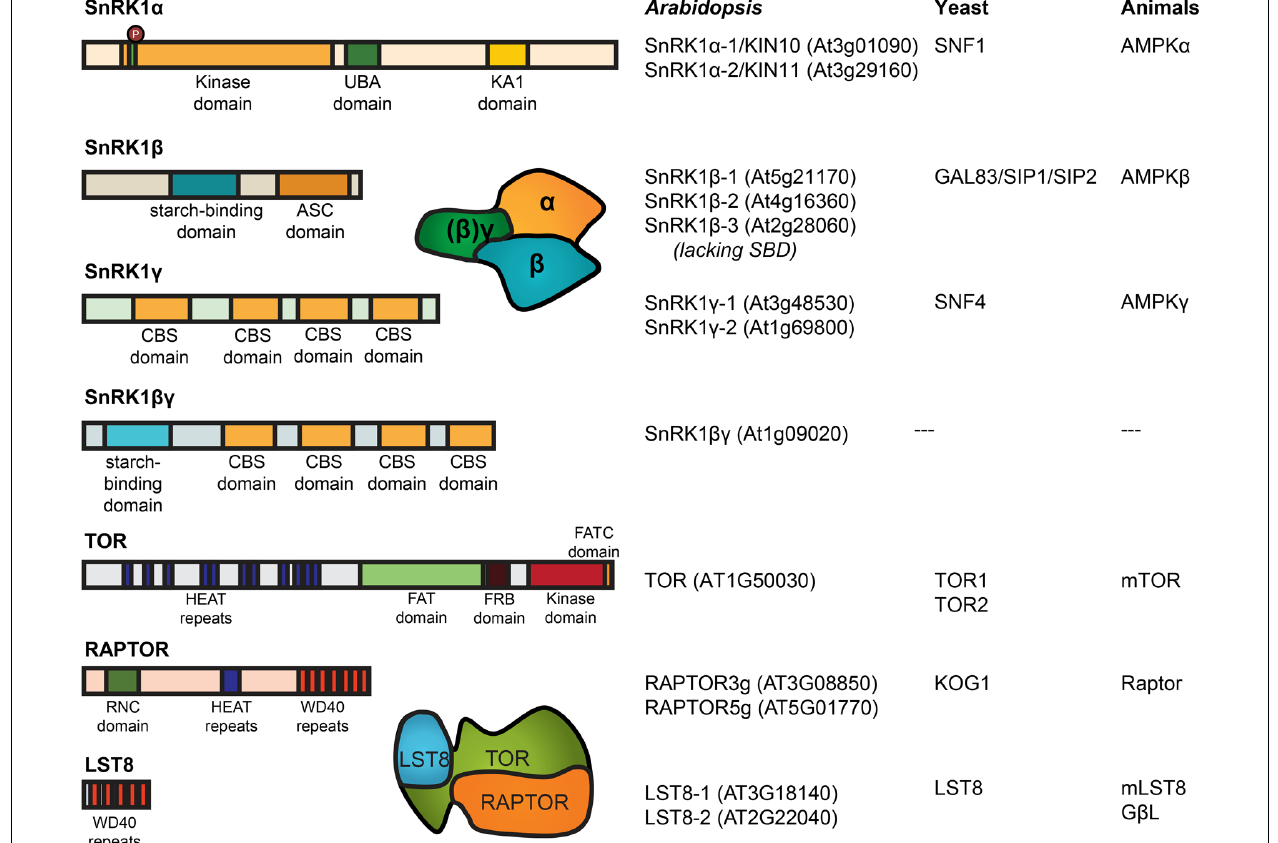
FIGURE 2 | Domain structure and nomenclature of Arabidopsis SnRK1 andTOR subunits. SnRK1 structures include the conserved phosphorylation sites onT-loop of the α -subunit.The α -subunit contains the kinase domain, together with an auto-inhibitory (UBA) domain and a kinase associated (KA1) domain where the interaction with the ß-subunit takes place.The β -subunit (except in SnRK1ß3) contains a starch-binding domain (Ávila-Castañeda etal., 2014) and binds to the γ -subunit at the association with the SNF1 complex (ASC) domain.The plant-specific βγ -subunit might take the place described for the γ -subunit in mammals and yeast, containing multiple cystathionine